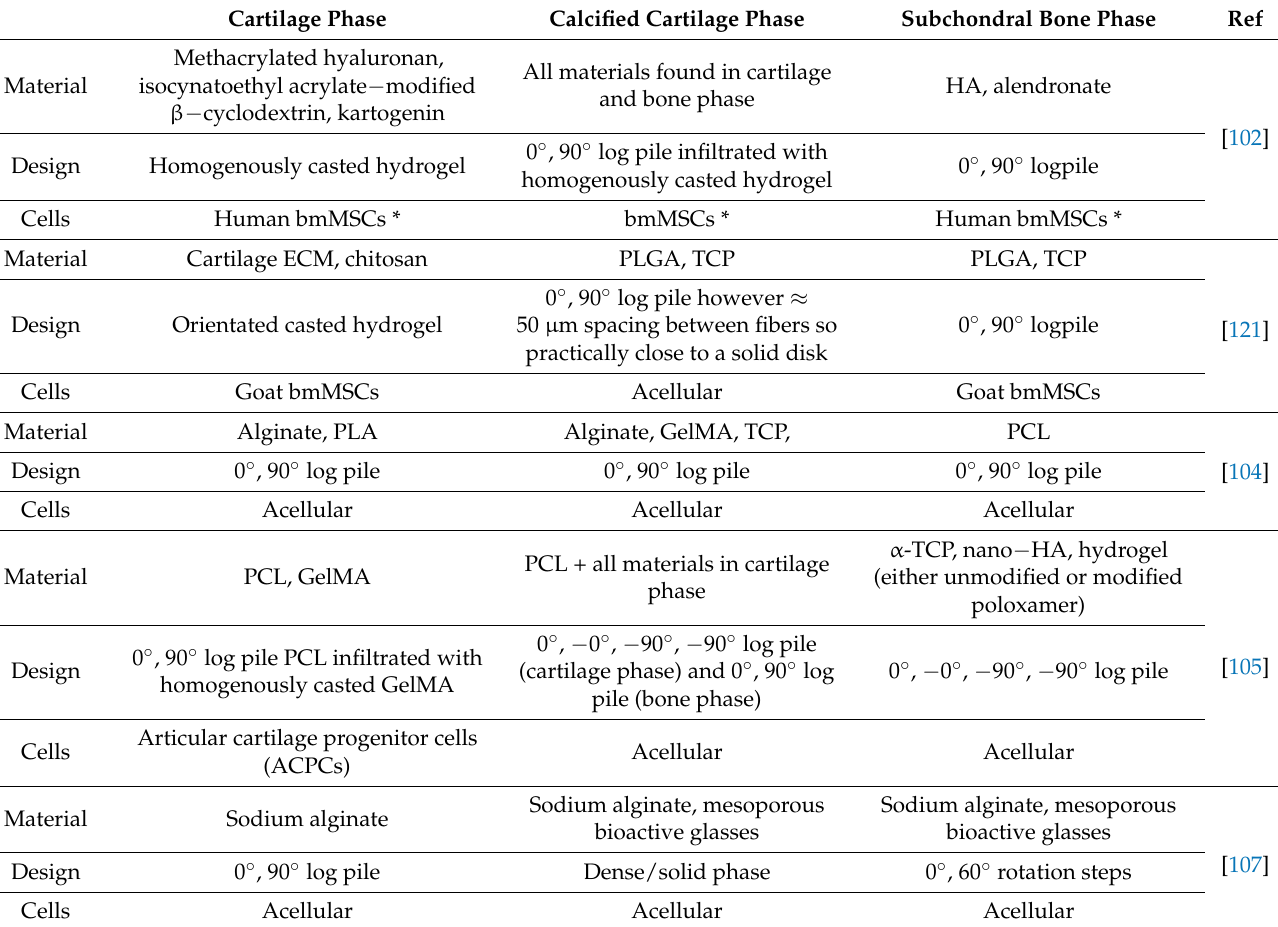
Table 2. Triphasic OC